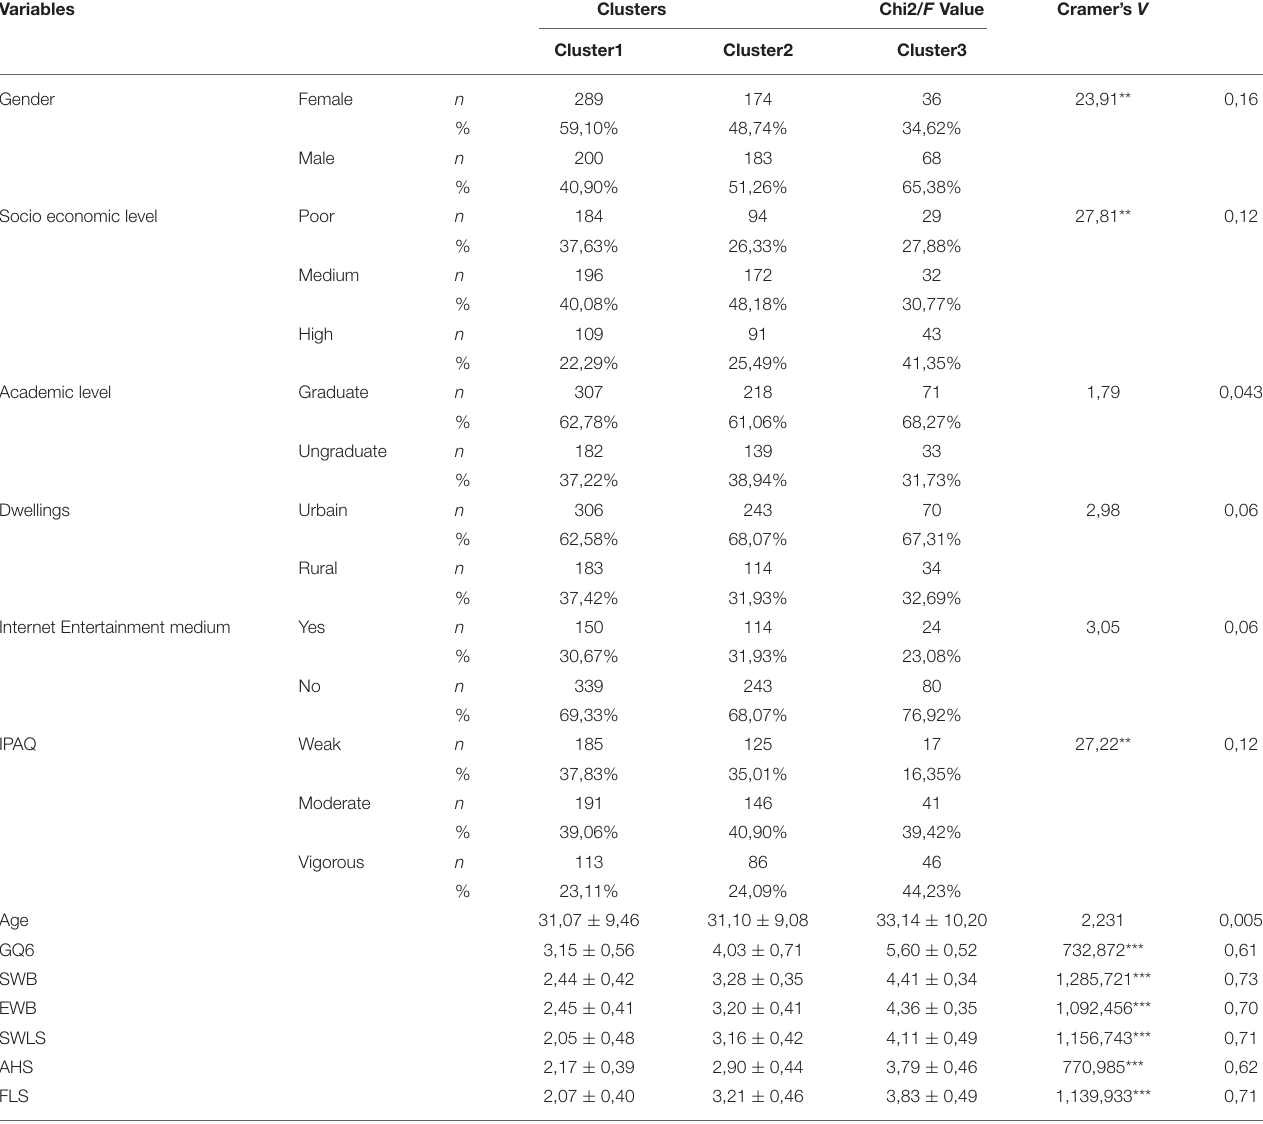
TABLE 2 | Characteristics of the three